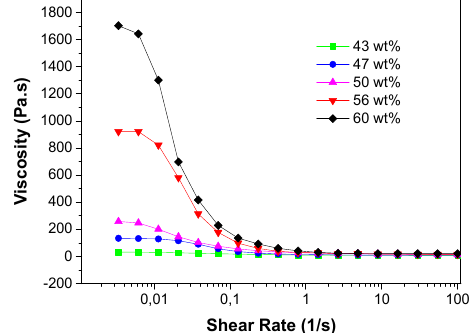
ff erent ceramic